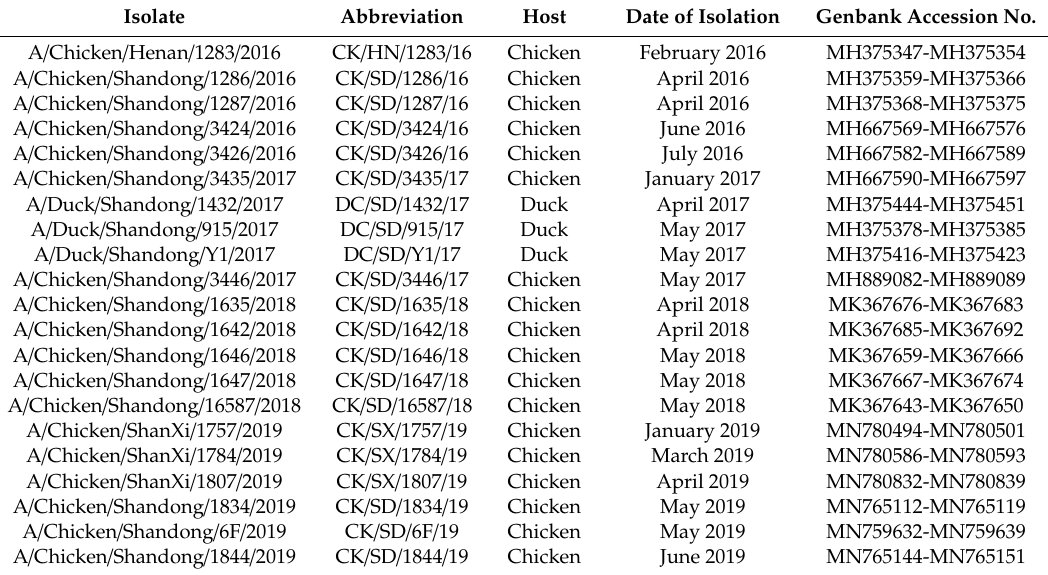
Table 1. H9N2 avian influenza virus (AIV) strains used in this study. Isolate Abbreviation Host Date of Isolation Genbank Accession